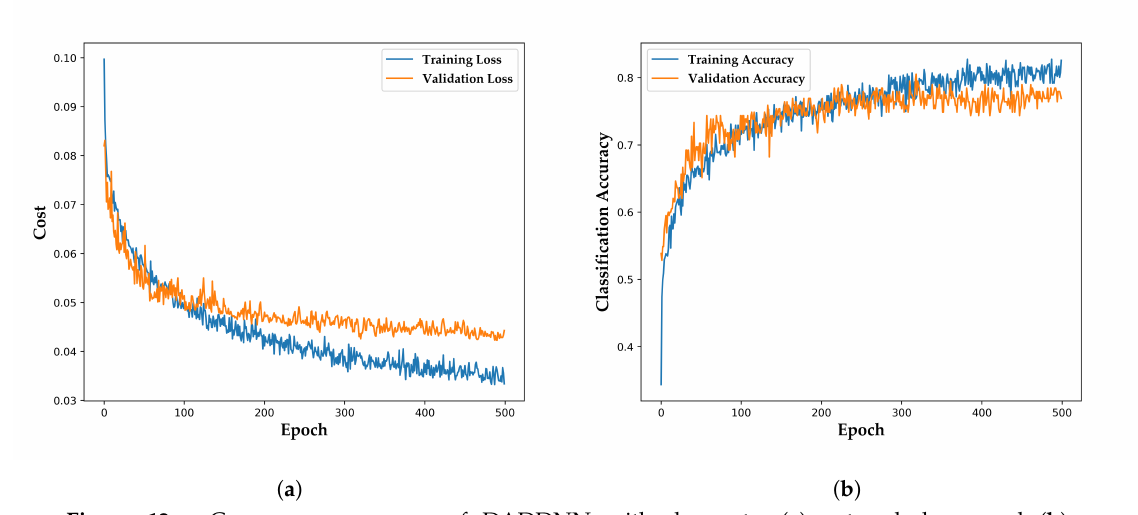
Figure 12. Convergence process of DADDNN with dropout: ( a ) network loss; and ( b ) diagnosis accuracy.